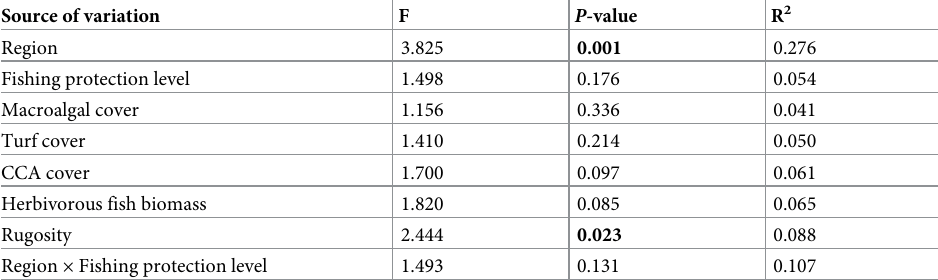
Table 1. Summary of the PERMANOVA to examine the influence of explanatory variables in the variation of composition of coral assemblages. Analyses are based on the Bray-Curtis dissimilarity index of the abundance of coral genera recorded at the 18 stations of the three regions. Significant P -values ( < 0.05) are highlighted in